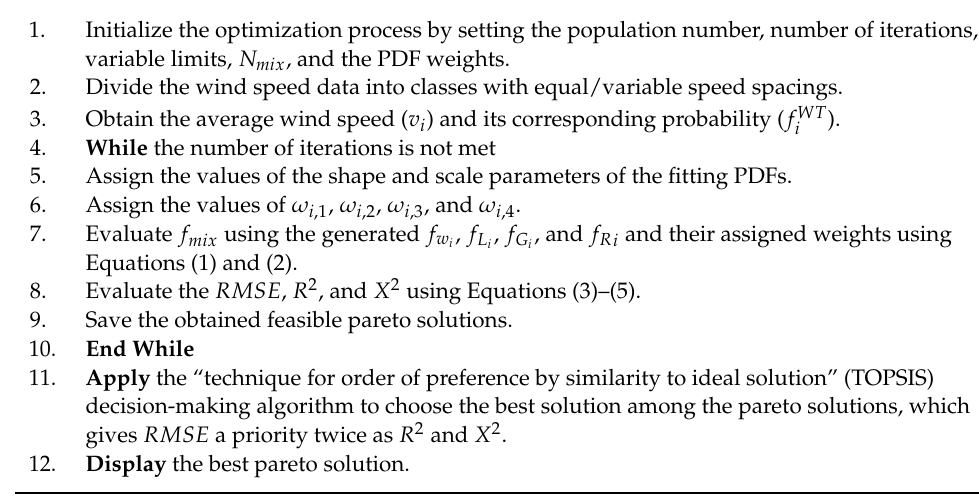
Algorithm 1 : Pseudo-code for the proposed multicriteria optimization process to optimally